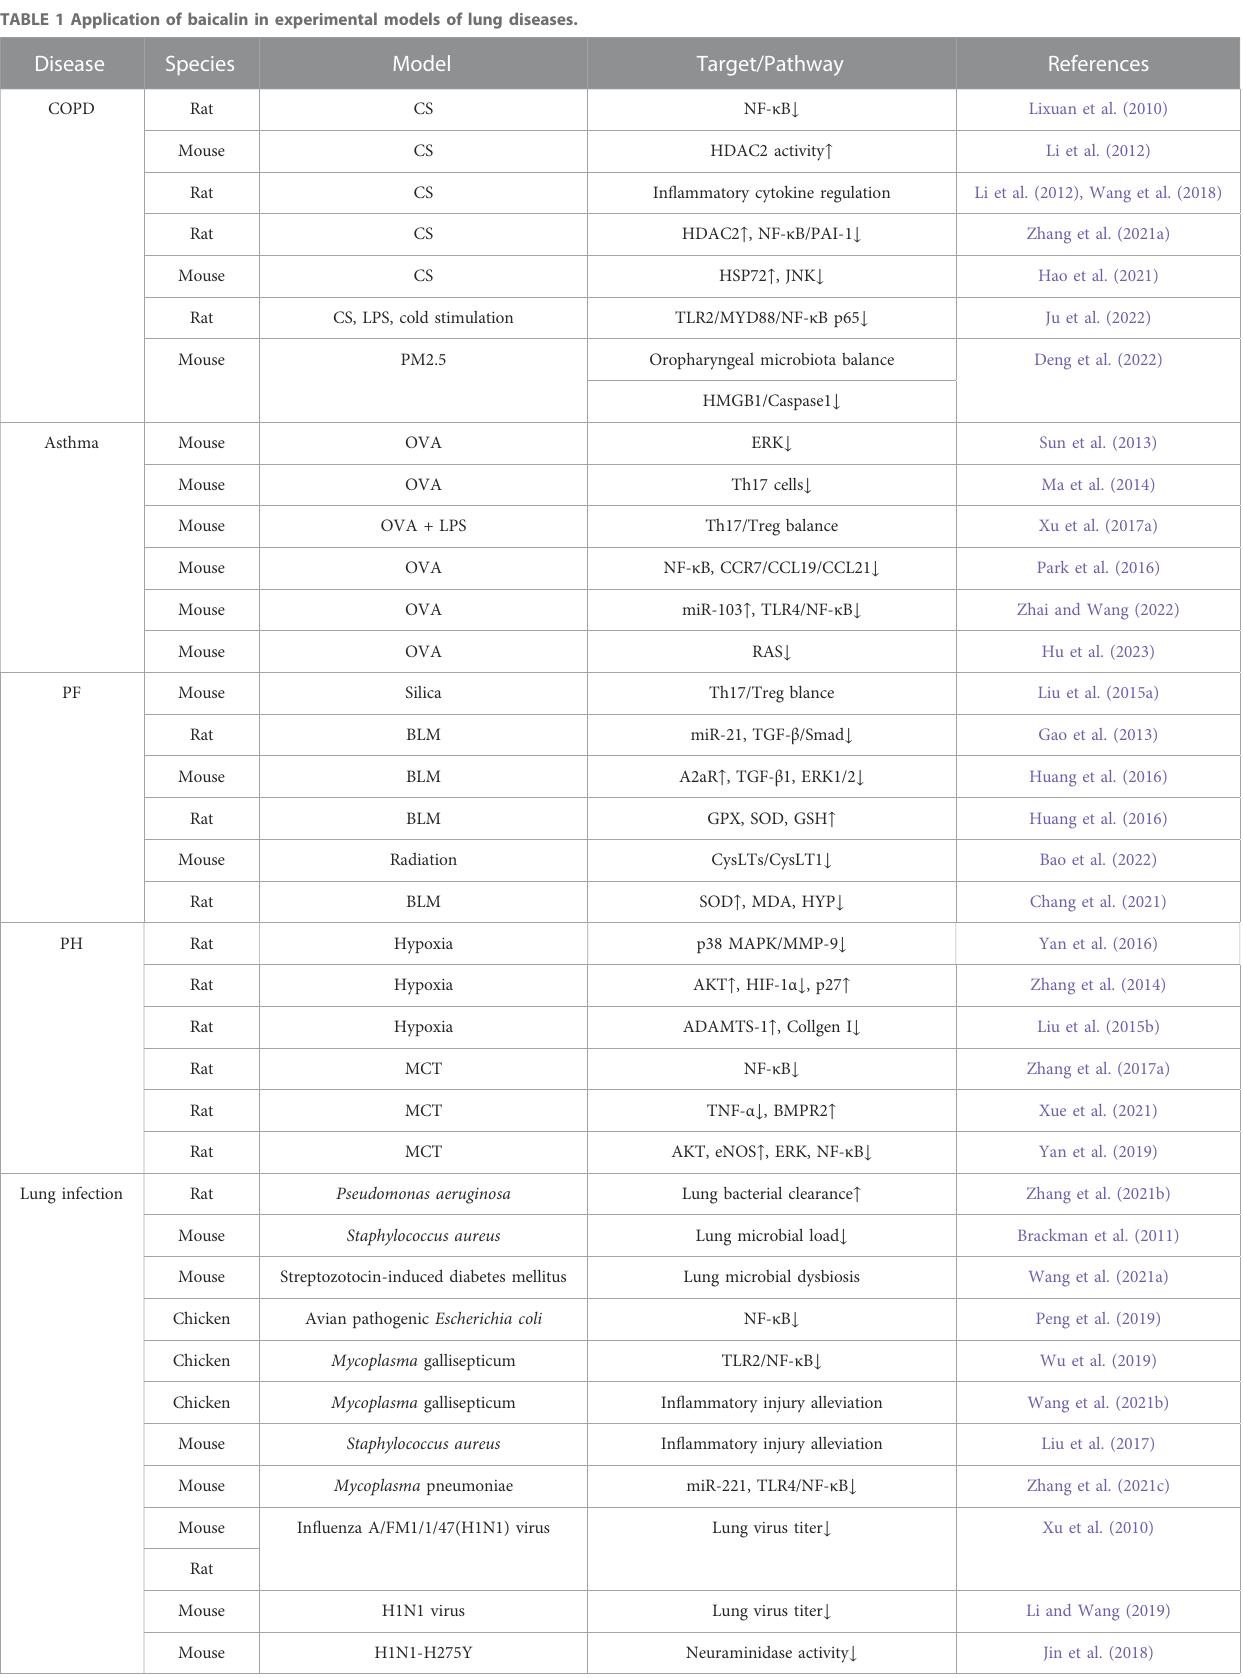
TABLE 1 Application of baicalin in experimental models of lung